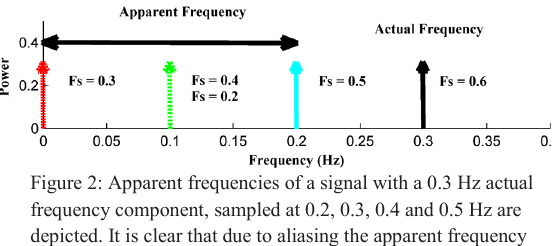
frequency component, sampled at 0.2, 0.3, 0.4 and 0.5 Hz are depicted. It is clear that due to aliasing the apparent frequency differs from the actual frequency in all cases.